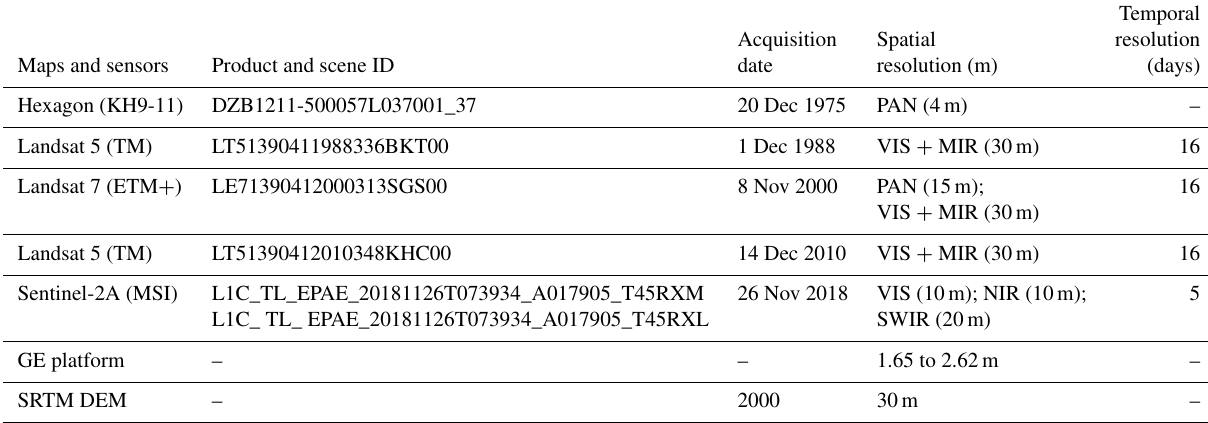
Table 1. Different datasets used in this current study for the analysis and its